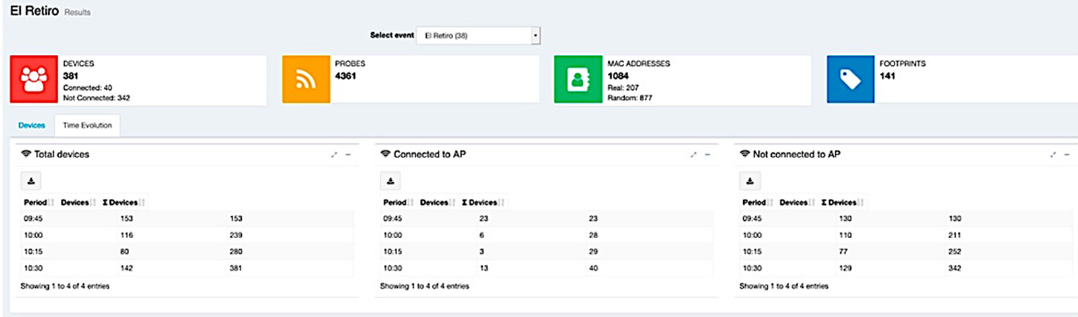
Figure 11. Information presented by the web application about the occupancy of a space where an event is organized.